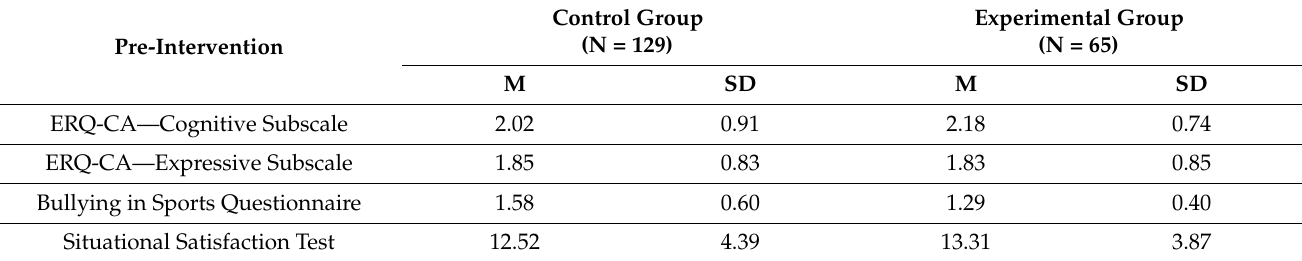
Table 3. Pre-intervention descriptive data for participants in the experimental and control group.